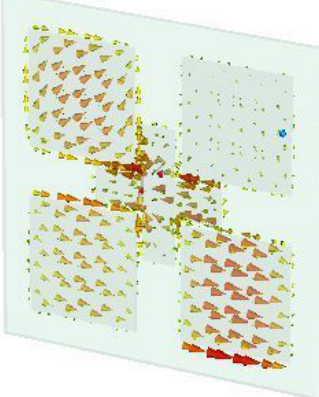
Figure 3. Current behaviour when the antenna is fed by port 1, and the upper right patch is out of resonance. More numerical results can be found in